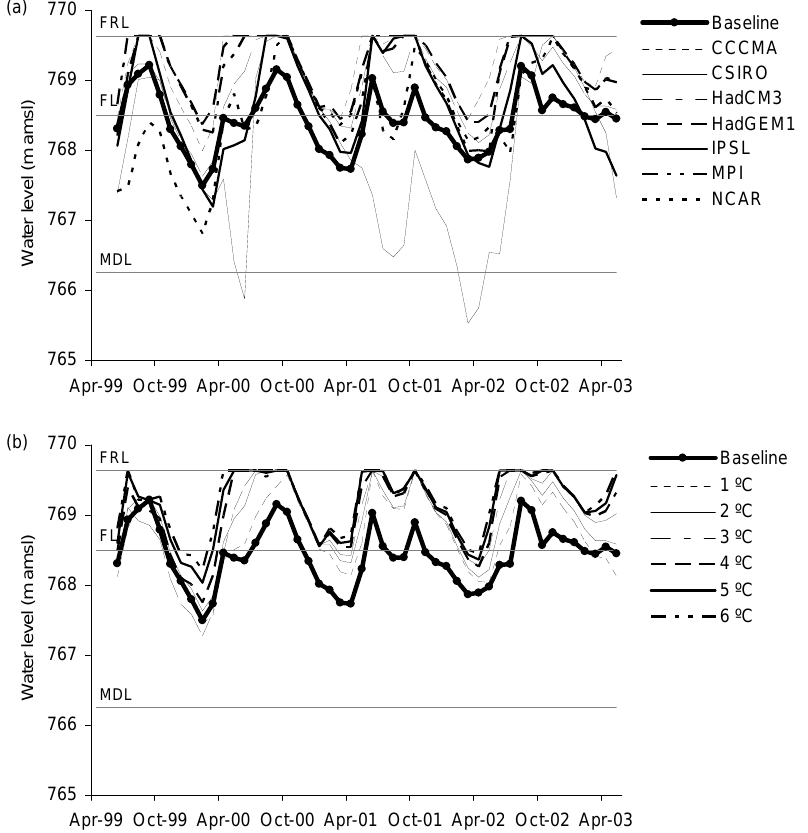
Fig. 9. Simulated mean monthly Loktak Lake water levels under baseline conditions (June 1999–May 2003) (a) Group 1 scenarios, (b) Group 2 scenarios (FRL: full reservoir level, FL: flood level, MDL: minimum drawdown